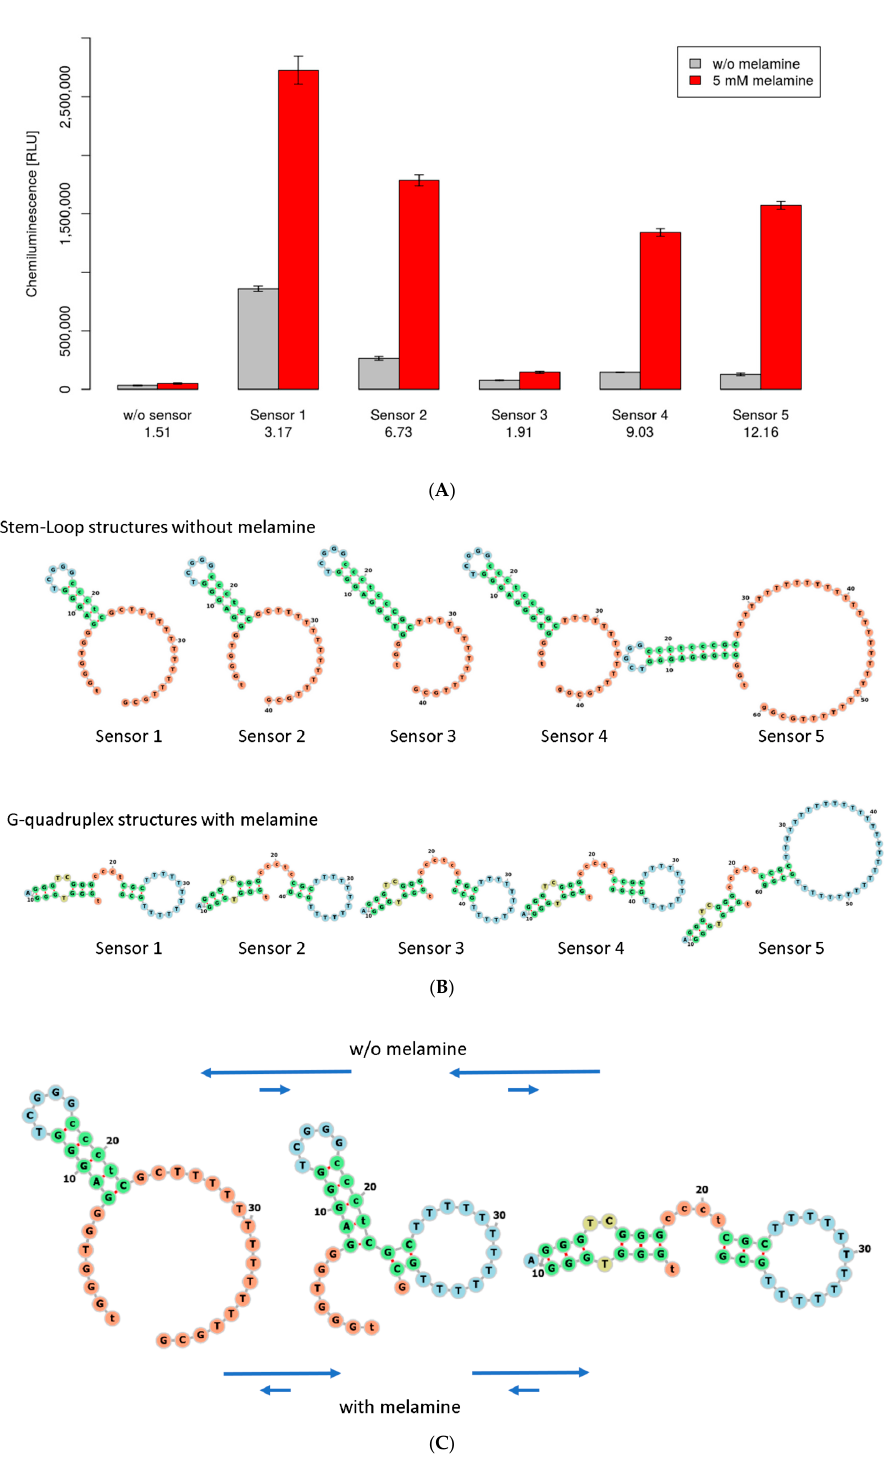
Figure 2. ( A ) The signal intensity for each step. The small vertical line in the bar chart represents the standard error (N = 3). Gray bars and red bars show the signal intensity without melamine and with 5 mM melamine, respectively. The signal-to-noise ratio for each step is shown at the bottom of the figure. ( B ) The estimated secondary structure of the biosensors at each optimization step. The top row and bottom row show the secondary structure without the G-quadruplex and with the G-quadruplex, respectively. The secondary structures were estimated with RNAfold [21] and generated with Forna [22]. ( C ) The change in the folding Sensor 1. The arrows show the equilibrium both without melamine and with